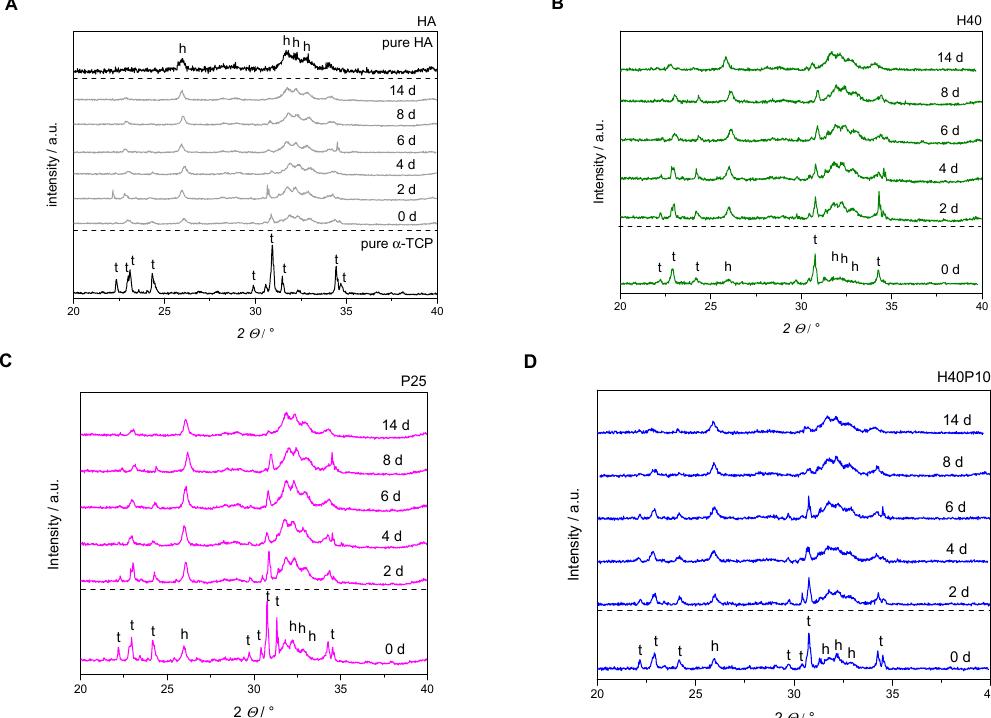
Figure 7. XRD-diffractograms of pure hydroxyapatite (HA) in comparison with composite batches. All formulations converted to HA over 14 days. With increasing polymer content, amorphous phases increased. Furthermore, a higher polymeric content also increased the time frame for HA formation (h = diffraction pattern HA, t = diffraction pattern α -TCP). ( A ) Inorganic reference HA in comparison to the reference diffraction pattern of pure α -TCP and HA, respectively; ( B ) HA with polymeric addition of 40 wt% HEMA (H40) in liquid phase; ( C ) HA with polymeric addition of 25 wt% synthesized hydrogel precursor (P25) in liquid phase; ( D ) HA with combination of 40 wt% HEMA and 10 wt% cross-linker (H40P10) in liquid phase.